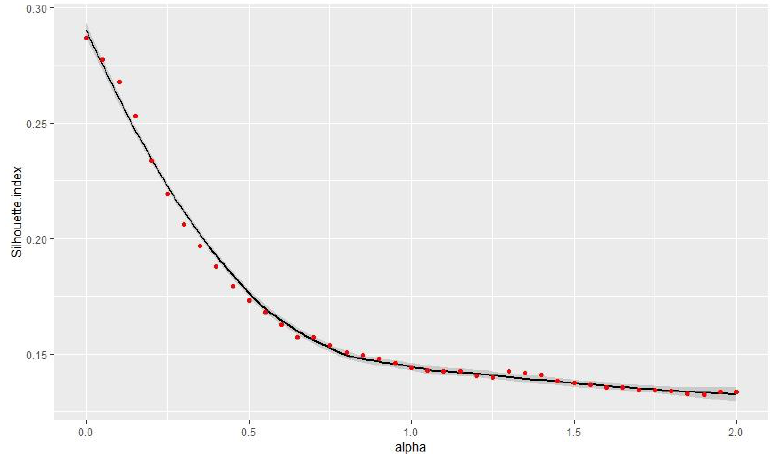
Figure 6. Link between alpha value and silhouette